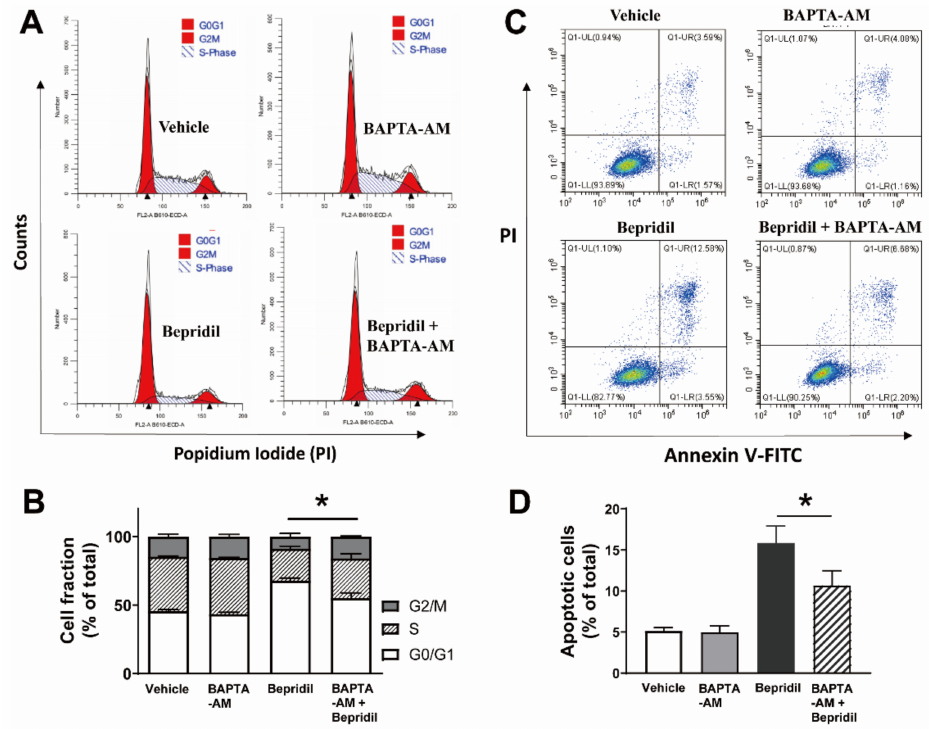
Figure 5. The Ca 2+ chelator BAPTA-AM prevented bepridil to induce cell cycle arrest and apoptosis. ( A , B ) Cell cycle profile of A2058 cells incubated with vehicle, BAPTA-AM (10 µ M), bepridil (25 µ M), and BAPTA-AM + bepridil for 18 h. BAPTA-AM alone did not incur cell fraction changes but significantly attenuated bepridil-induced cell cycle arrest. * p < 0.05, G 0 /G 1 phase of bepridil vs. BAPTA-AM + bepridil, n = 5 independent experiments. ( C , D ) A2058 cells treated with vehicle, BAPTA-AM (10 µ M), bepridil (25 µ M), and BAPTA-AM + bepridil for 24 h. * p < 0.05, apoptotic cell fraction in bepridil treatment vs. BAPTA-AM + bepridil; one-way ANOVA followed by a Tukey’s post hoc test, n =